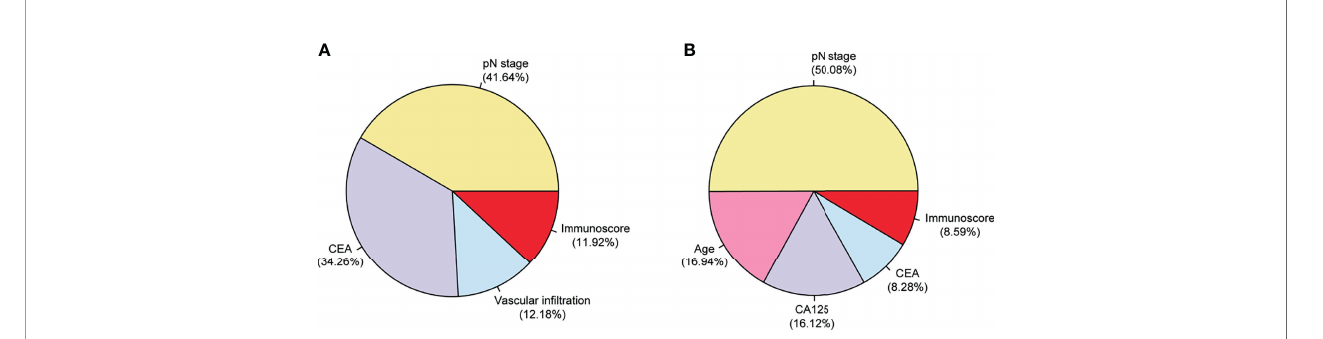
FIGURE 3 | Relative contributions (in percent) of each variable to DFS/OS in the fi nal multivariable Cox models in 254 patients with stage II – III colorectal cancer (CRC). The relative importance of each variable to the risks of DFS (A) and OS (B) . OS, overall survival; DFS, disease-free